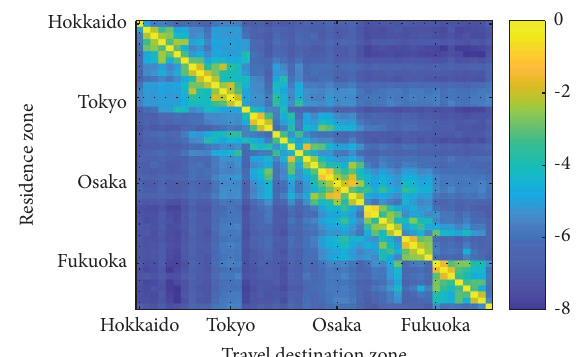
Figure 8: Estimated travel cost ( C